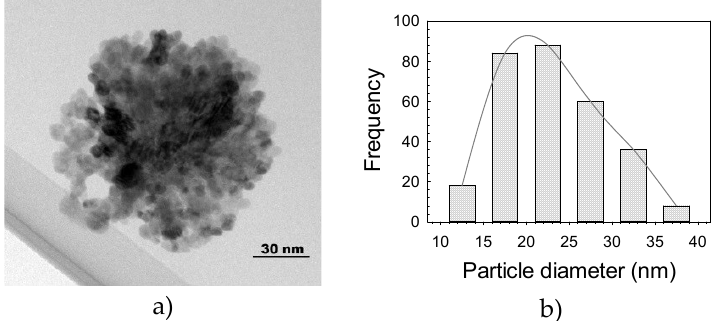
Figure 2. Transmission electron microscopy micrograph showing the spherical morphology of ZnO-NPs ( a ) and histogram of particle size distribution ( b ).